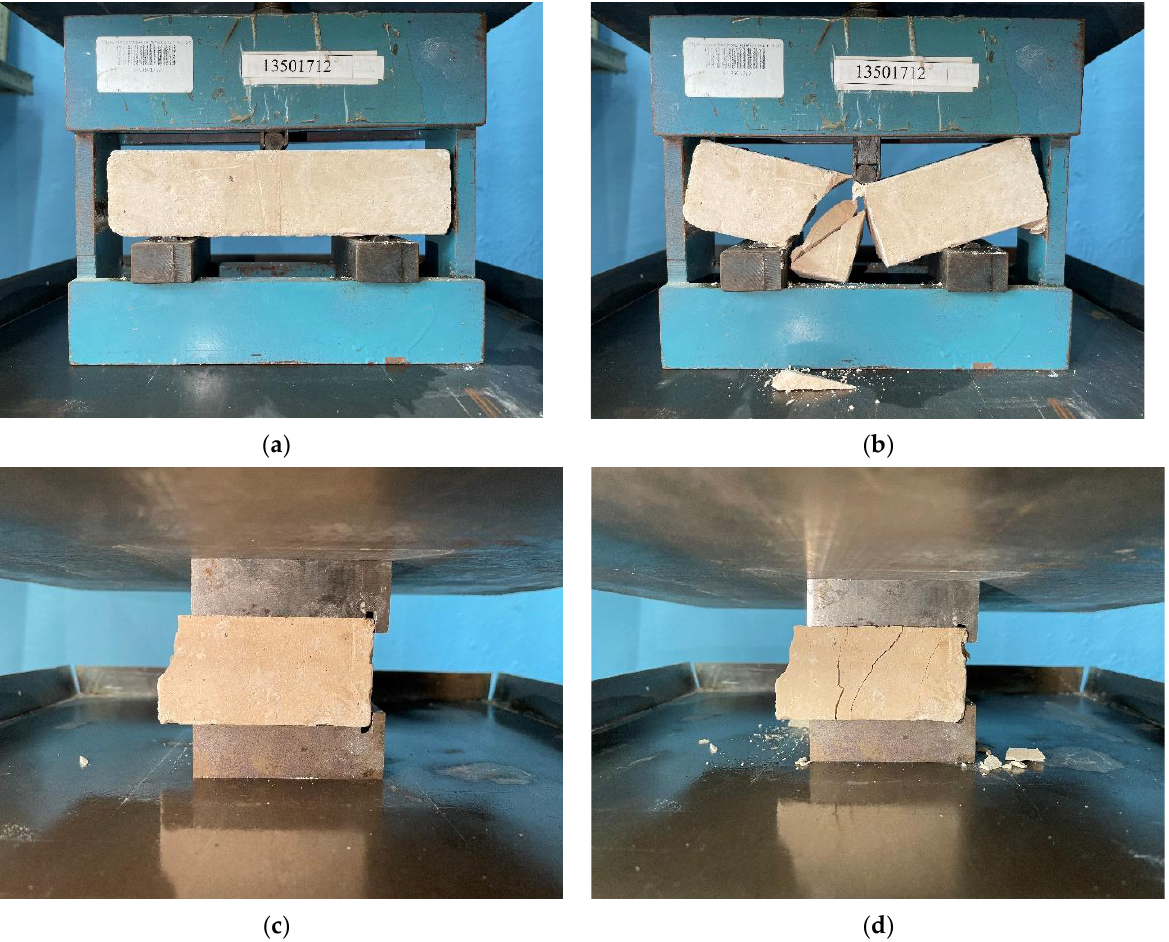
Figure 4. Testing specimens for bending strength ( a , b ) and compressive strength ( c , d ) before collapse and after collapse, respectively.